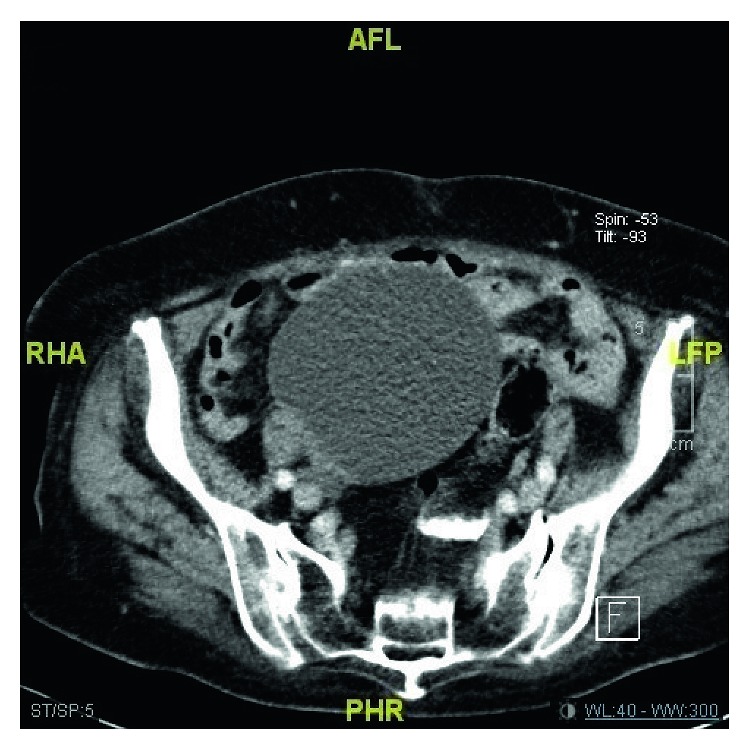
Huge adnexal mass.